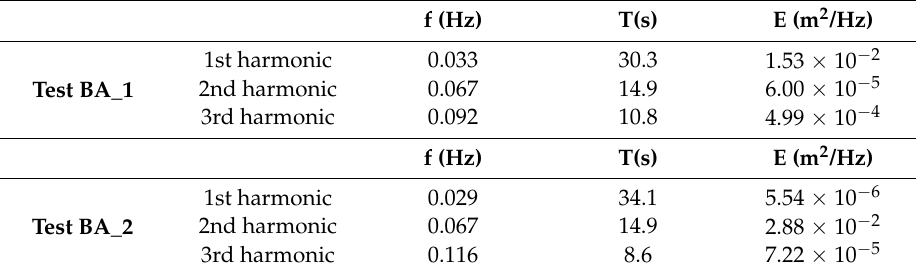
Table 4. Peak frequencies, periods and power spectral density for BA_1 and BA_2 tests.